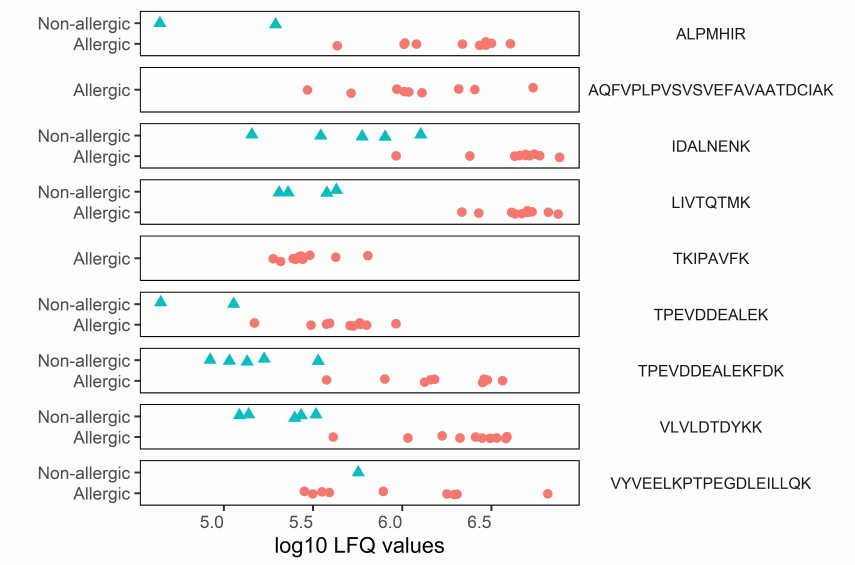
Figure 3. Categorical scatterplot showing non-imputed, 10 log transformed LFQ intensities of peptide sequences that were found in significantly higher levels in milk from allergic mothers. Allergic mothers are represented by red circles, and nonallergic mothers are represented by blue